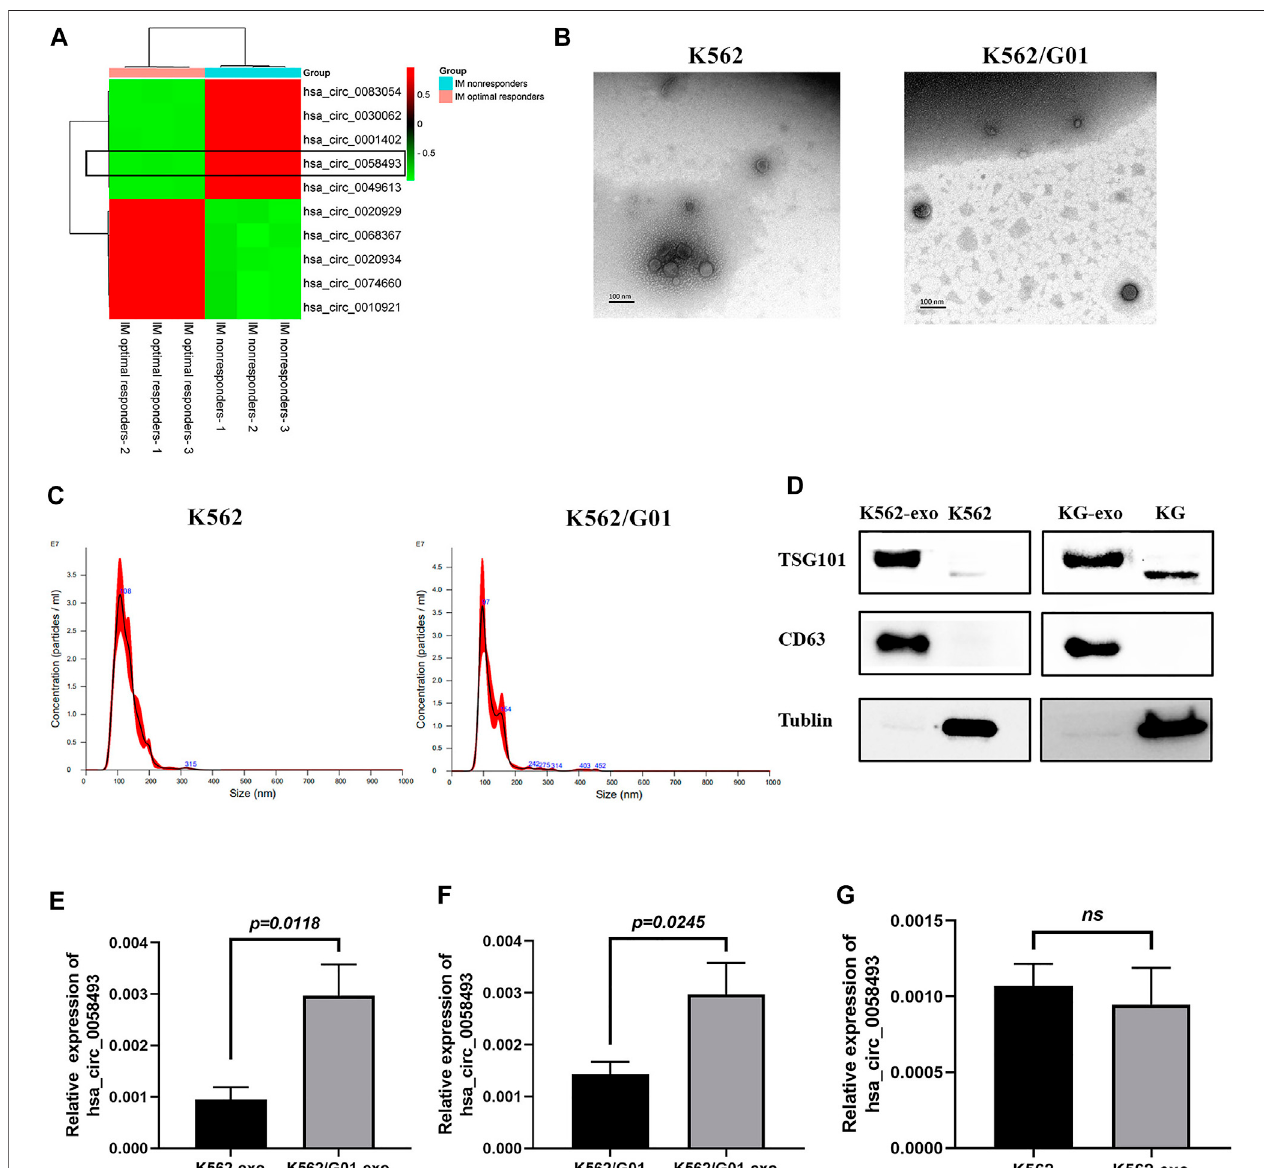
FIGURE5| Theexpressionlevelofhsa_circ_0058493inexosomesisassociatedwithimatinibresistance. (A) Weselectedtop fi veupregulatedanddownregulated circRNAs (including circ58493) from the results of microarray analysis, normalized intensities of each selected circRNA were used to make the heat map. Hsa_circ_0058493 was framed to show that it was intensely overexpressed in plasma of IM nonresponders compared with IM optimal responders. (B) The exosomes isolated from K562/G01 and K562 culture medium by ultracentrifugation showed a typical cup shape under TEM. (C) The exosomes isolated from K562/G01 and K562culturemediumbyultracentrifugationshoweddiametersofmostoftheparticlesare30-150 nmthroughNTA. (D) TheexosomesisolatedfromK562/G01(KG)and K562 culture medium expressed exosome marker CD63 and TSG101 analyzed by western blot. (E) Circ_0058493 in K562/G01 exosomes was signi fi cantly overexpressed by 3.14-fold compared with K562 exosomes ( p (cid:1) 0.0118). (F) The expression level of circ_0058493 in the exosomes derived from K562/G01 was increased by 2.08-fold compared with K562/G01 ( p (cid:1) 0.0245). (G) Circ_0058493 expression in exosomes derived from K562 showed no difference with K562. Quantitative data from three independent experiments are shown as the mean ± SD (error bars). ns: not statistically signi fi cant (Student ’ s t -test).